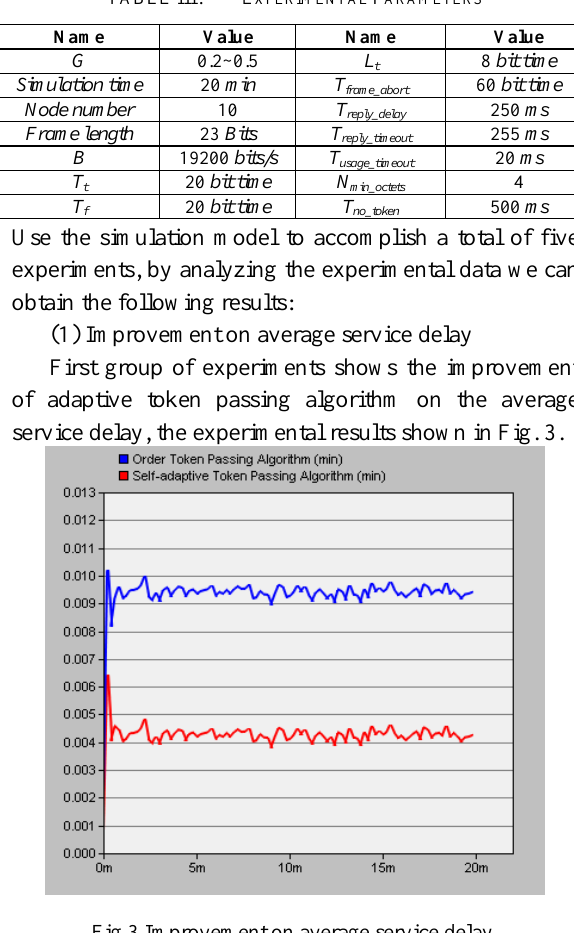
Fig.3 Improvement on average service